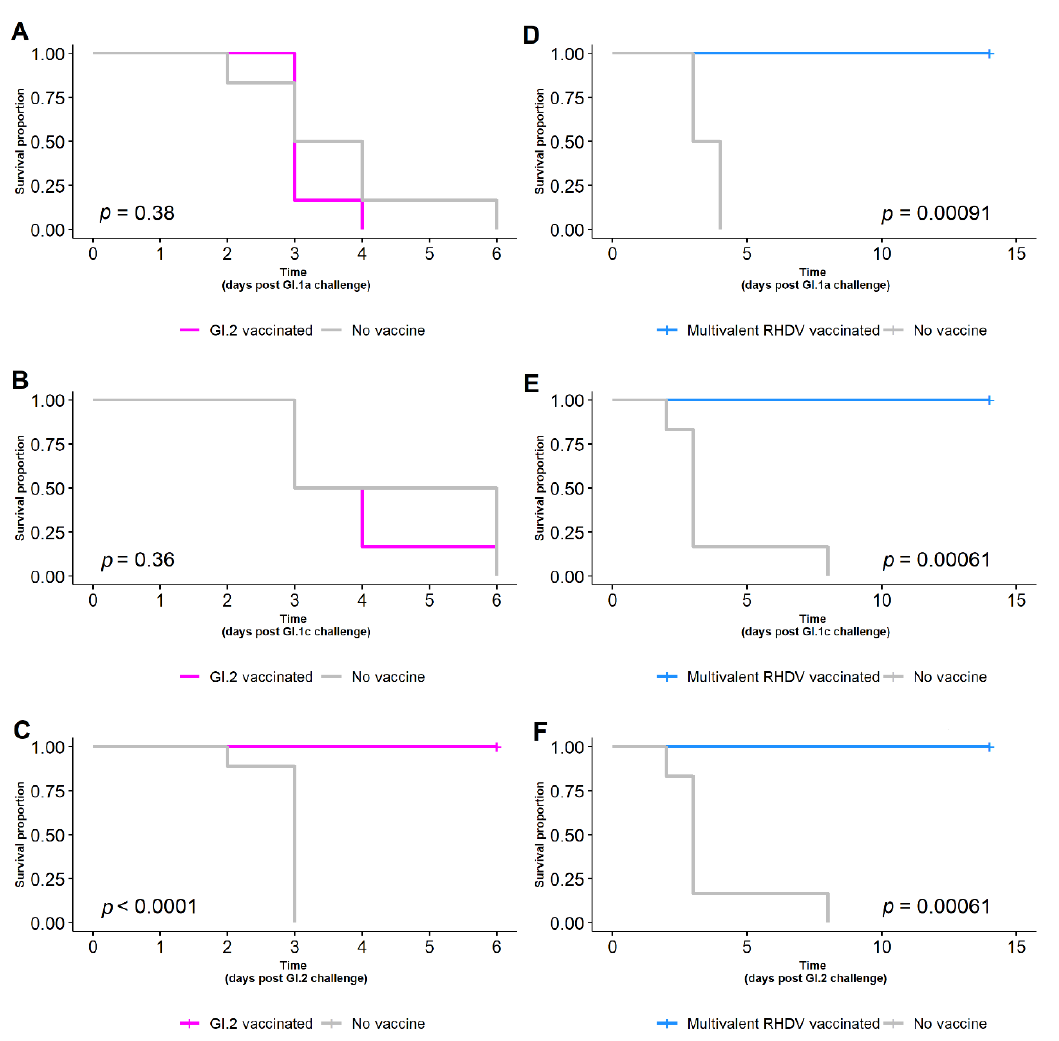
Figure 4. Survival curve of rabbits given a GI.2-specific vaccine ( A – C , magenta), multivalent RHDV vaccine ( D – F , blue), or no vaccine ( A – F , grey) and challenged with 1500 RID 50 of GI.1a, GI.1c or GI.2. While the GI.2-specific vaccine provided complete protection against GI.2 challenge, only the rabbits given the multivalent RHDV vaccine were protected against GI.1a, GI.1c and GI.2 challenge. Table 2. Proportion of vaccinated rabbits that succumbed to rabbit hemorrhagic disease following oral inoculation with Australian lagoviruses.